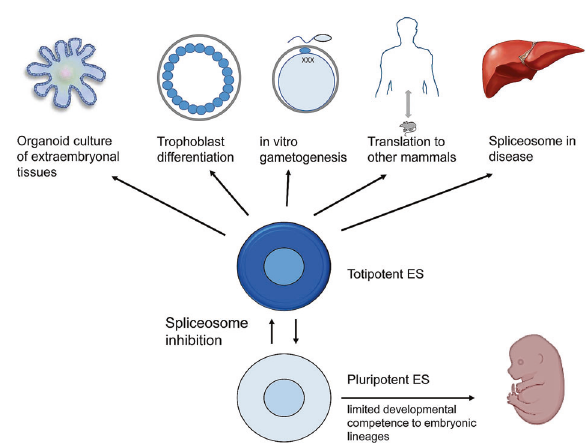
Fig. 1 Potential applications of totipotent ES cells. Spliceosome targeting by RNA interference or the speci fi c inhibitor pladienolide B seems to convert pluri- to totipotent ES cells, which were shown to have a bi-directional developmental capacity to embryonic and extra-embryonic cell lineages: 1 allowing to explore in vitro differ- entiation of extra-embryonal tissue and organoids, translation to the maintenance of pluripotent cells of other mammal species, a better molecular understanding of cellular potency in stem cells and cancer, and potentially to develop more speci fi c therapeutic